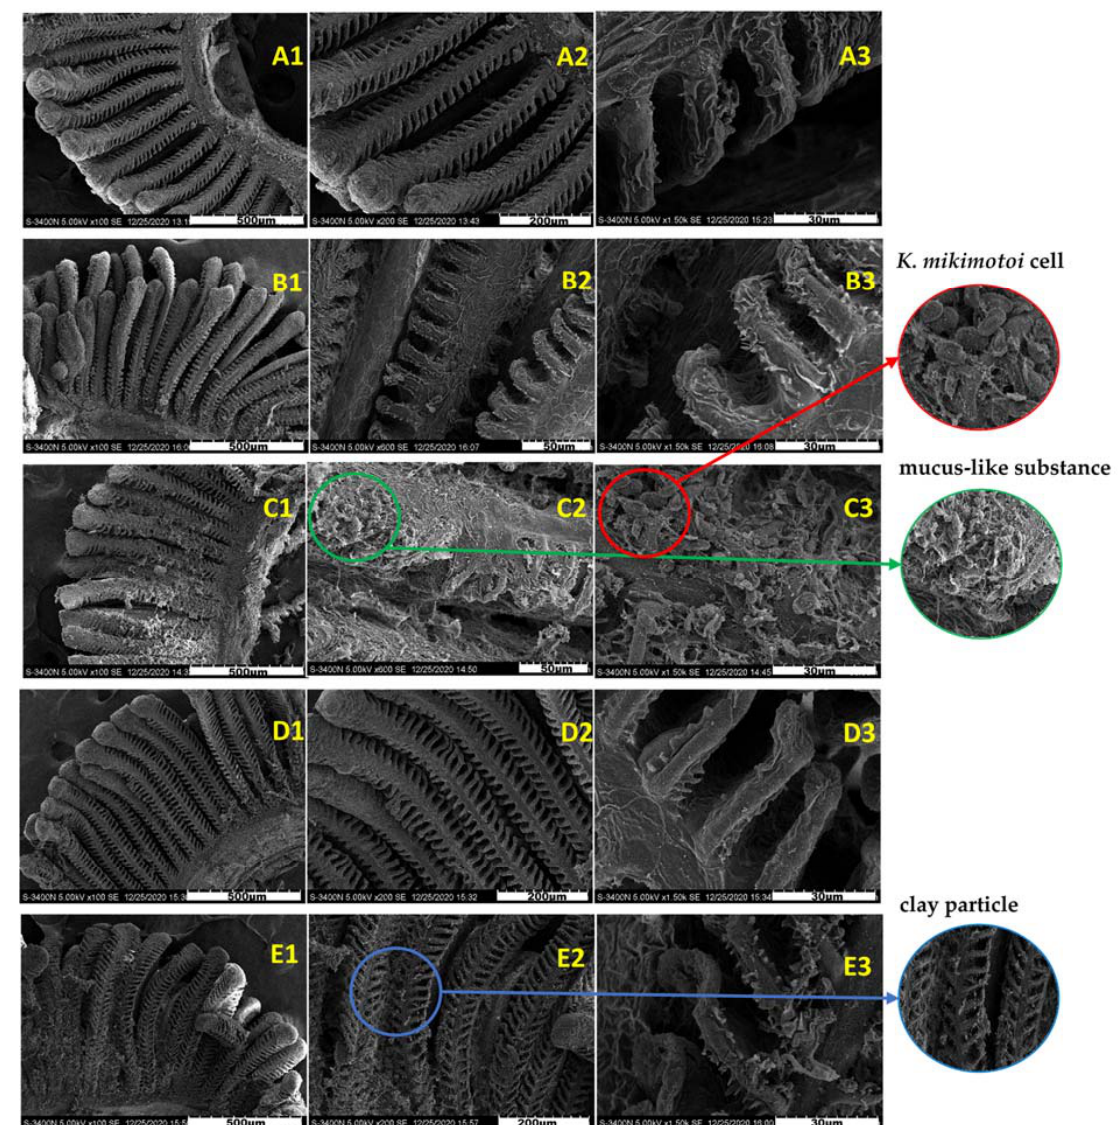
Figure 3. Surface morphology of the gills of different groups of marine medaka. ( A1 – A3 ) Surface. morphology of the normal gills in SW group. ( B1 – B3 ) Surface morphology of the gills exposed by MC. ( C1 – C3 ) Surface morphology of the gills exposed to K. mikimotoi . ( D1 – D3 ) Surface morphology of gills exposed in the KMMC group for 3 h. ( E1 – E3 ) Surface morphology of the gills exposed to KMMC for 24 h.